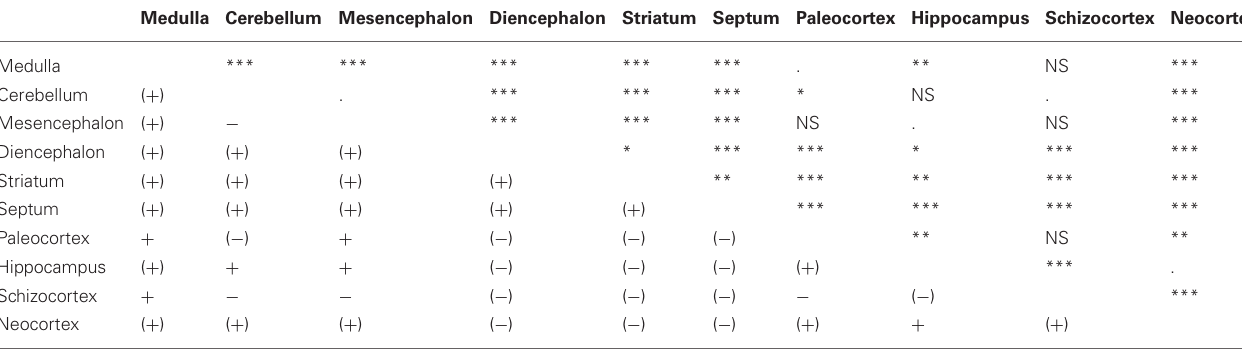
Table 1 | Differences between carnivore and simian cerebrotypes (human species